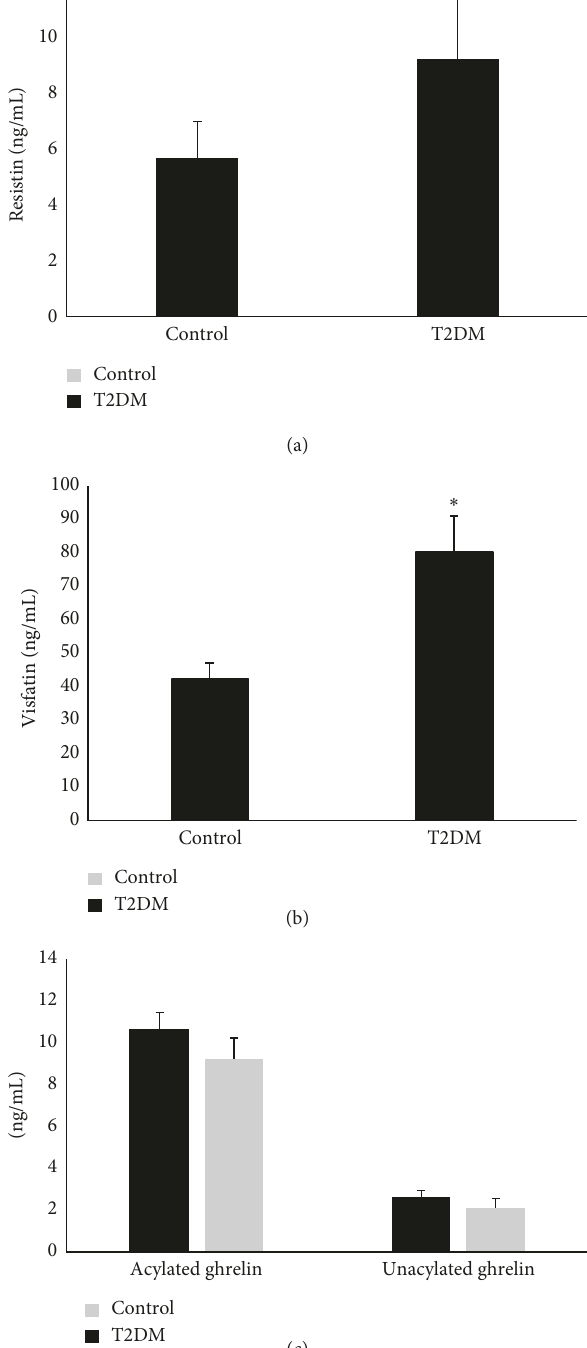
Figure 2: Salivary resistin, visfatin, and ghrelin in T2DM: Unstimulated whole saliva (UWS) was collected from 20 T2DM individuals and 20 healthy individuals. Each UWS sample was depleted of amylase and immunoglobulins. Precleaned UWS was assessed for (a) resistin, (b) visfatin, and (c) acylated and unacylated ghrelin using specific assay kits. ∗ p < 0 .